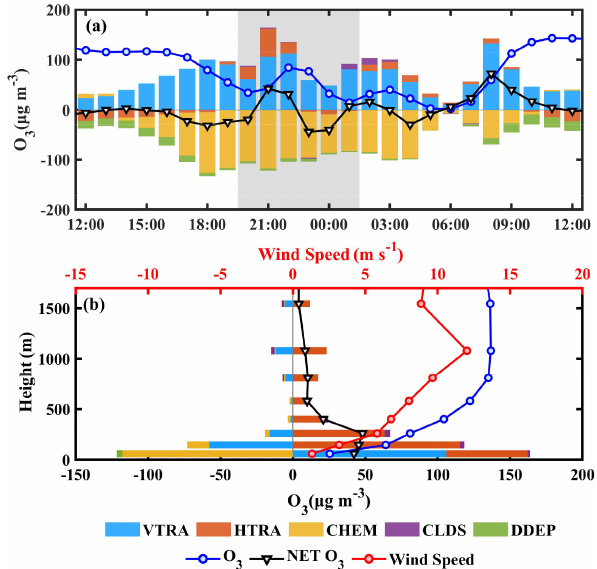
Figure 10. Contribution of individual processes to (a) hourly O 3 concentration near the surface during 13–14 September 2017 and (b) vertical O 3 concentration at 21:00LT on 13 September 2017. VTRA: vertical transport, the net effect of vertical advection and diffusion; HTRA: horizontal transport, the net effect of horizon- tal advection and diffusion; CHEM: gas-phase chemistry; CLDS: cloud processes; DDEP: dry deposition; NET: the net change in O 3 due to all atmospheric